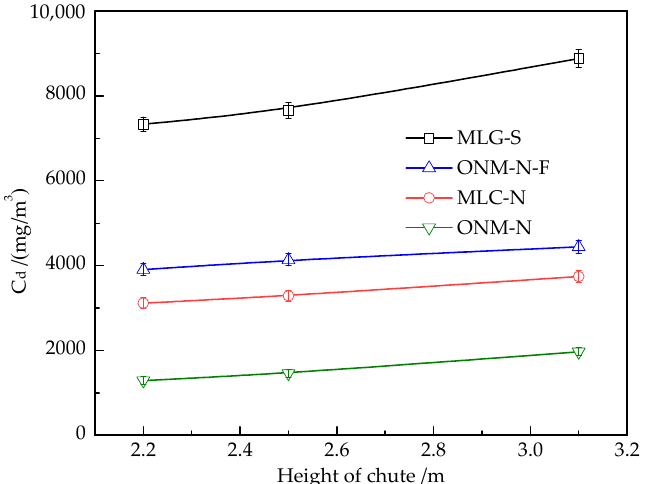
Figure 5. Effects of the height of chute on the average dust concentration of chute at the three meas- uring points.